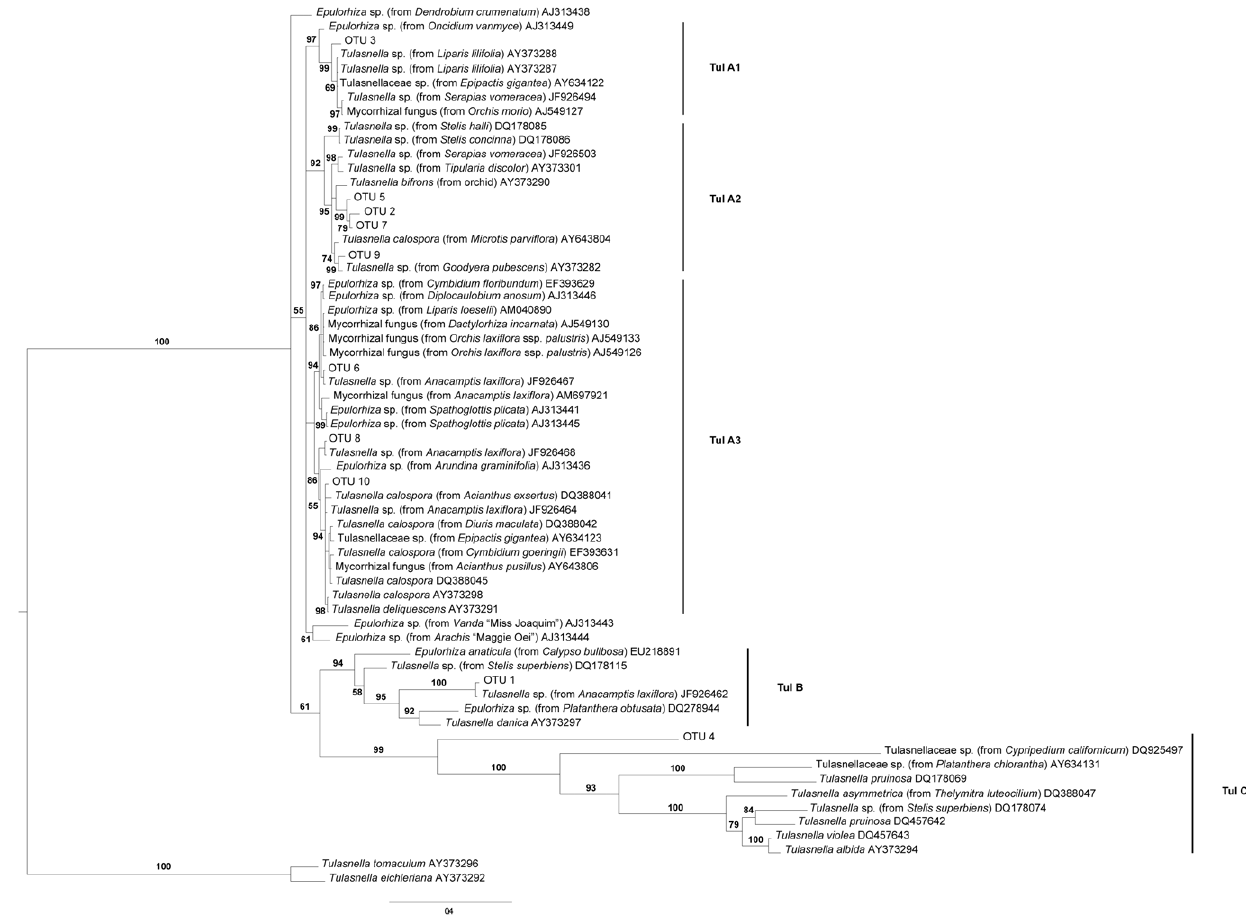
Figure 1. Bayesian majority consensus tree based on internal transcribed spacer (ITS) sequences of Tulasnellaceae fungi. The tree was computed under the GTR + G substitution model (5 000 000 generations run) and includes representatives of European, American, and Australian meadow and forest photosynthetic orchids, tropical terrestrial and epiphytic orchids, non-orchid species and fungal strains and fruitbodies. Tulasnella tomaculum and Tulasnella eichleriana were used as outgroup taxa. Branch support: Bayesian posterior probabilities (BPP).